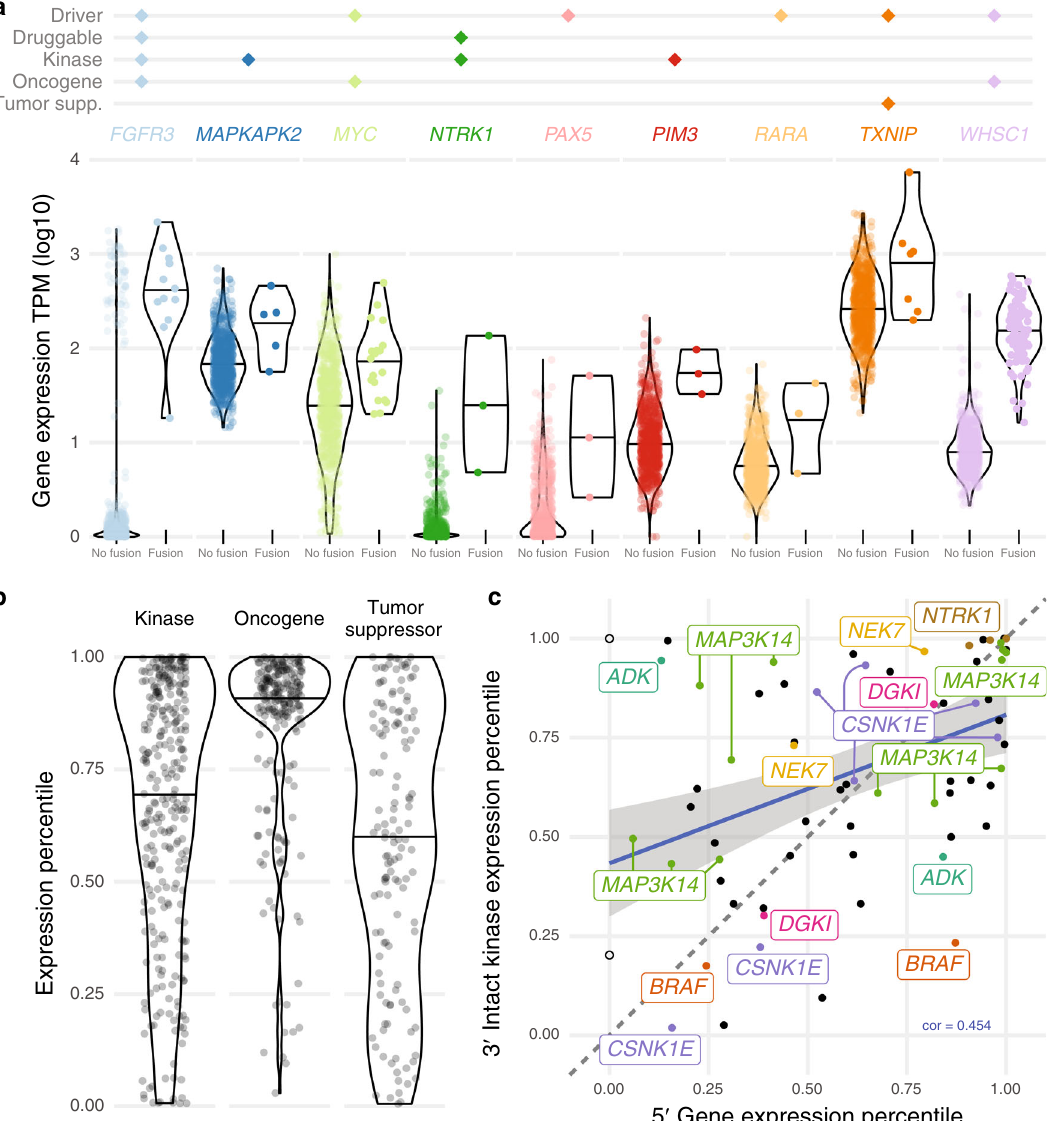
Fig. 2 Expression of cancer-related genes. a Signi fi cantly overexpressed fusion genes. Violin plots de fi ned as: FGFR3 no fusion (n = 730, minimum = 0.00, maximum = 3.26, median = 0.05), fusion (12, 1.26, 3.34, 2.58); MAPKAPK2 no fusion (737, 1.16, 2.85, 1.83), fusion (5, 1.75, 2.66, 2.36); MYC no fusion (723, 0.03, 3.00, 1.39), fusion (19, 1.30, 2.69, 1.89); NTRK1 no fusion (739, 0.00, 1.55, 0.03), fusion (3, 0.68, 2.13, 1.39); PAX5 no fusion (739, 0.00, 1.88, 0.11), fusion (3, 0.42, 1.71, 1.05); PIM3 no fusion (739, 0.00, 2.32, 0.99), fusion (3, 1.51, 1.99, 1.73); RARA no fusion (739, 0.00, 1.83, 0.75), fusion (3, 0.67, 1.63, 1.31); TXNIP no fusion (735, 1.31, 3.43, 2.41), fusion (7, 2.3, 3.87, 3); WHSC1 no fusion (645, 0.33, 2.57, 0.91), fusion (97, 1.21, 2.77, 2.19). All data points from 0 to 100th percentile are shown. b Expression percentile distribution for different gene classes. Violin plots de fi ned as: Kinase ( n = 298, minimum = 0.01, maximum = 1.00, median = 0.74); Oncogene (224, 0.03, 1.00, 0.92); Tumor Suppressor (137, 0.01, 1.00, 0.61). All data points from 0 to 100th percentile are shown. c . 5 ′ and 3 ′ gene expression of fusions with intact 3 ′ kinase genes. The two empty circles have no expression value for the 5 ′ gene (IGH, IGL). Labels refer to genes appearing more than once. Source data and scripts are available at https://doi.org/10.6084/m9. fi